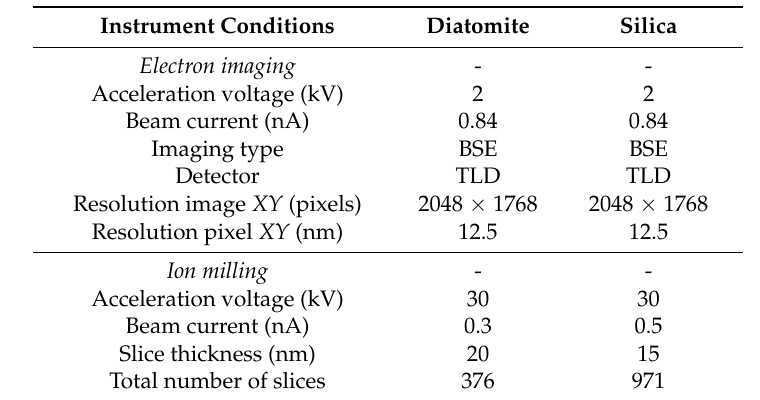
Table 1. Imaging conditions for the serial sectioning performed on porous diatomite and silica materials demonstrated in the present